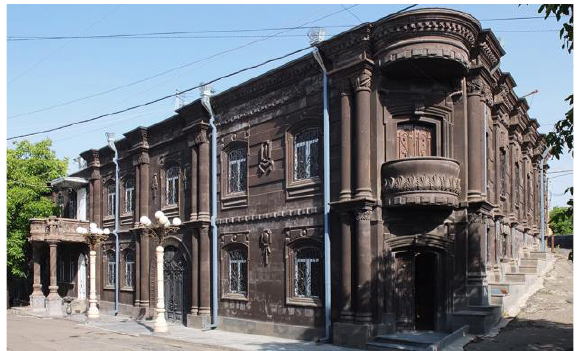
Figure 19. New black tuff houses built in the 2000s, Mayakovsky Street. Photo by the author, 2018.